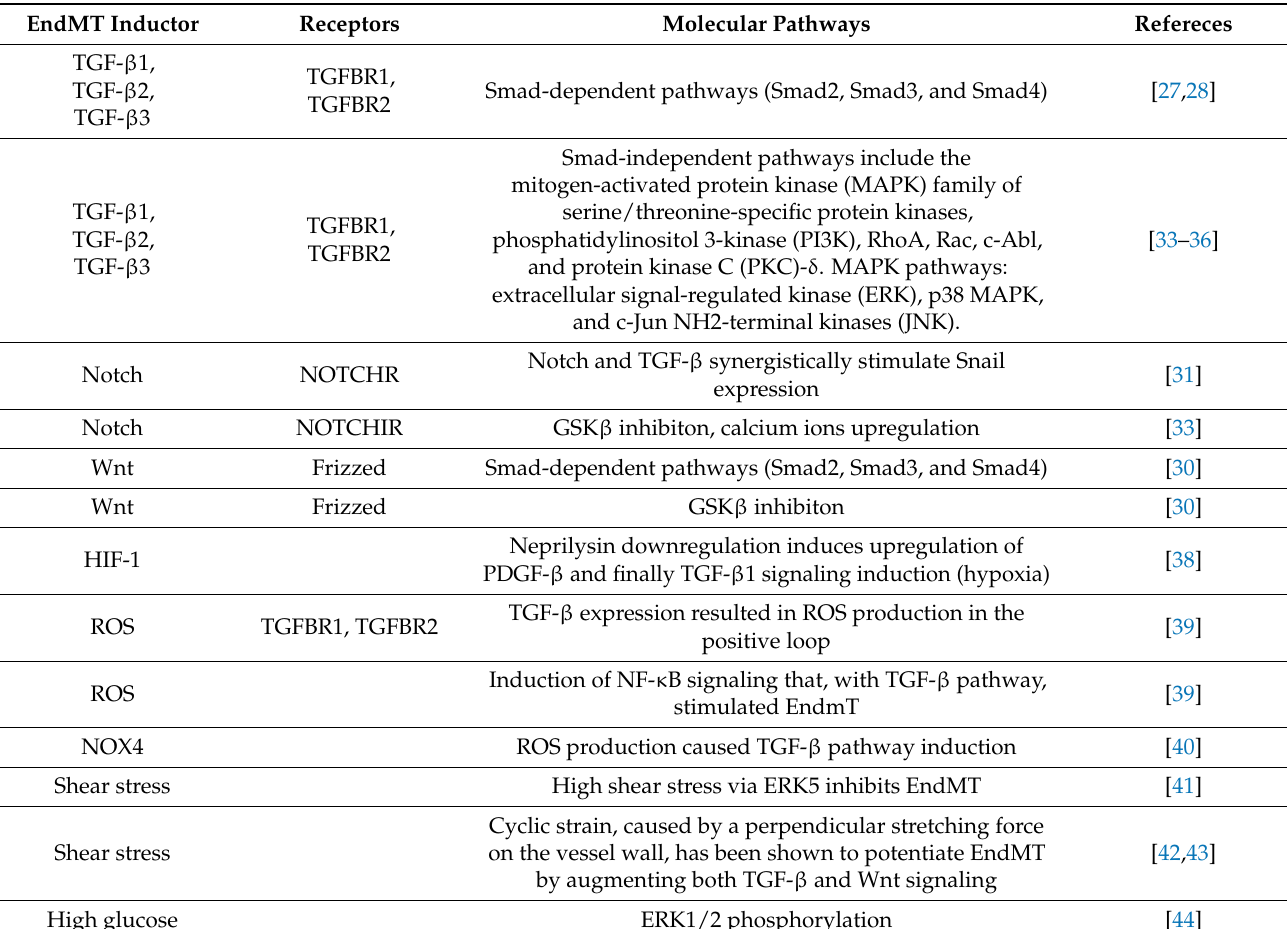
Table 1. Molecular pathways involved in